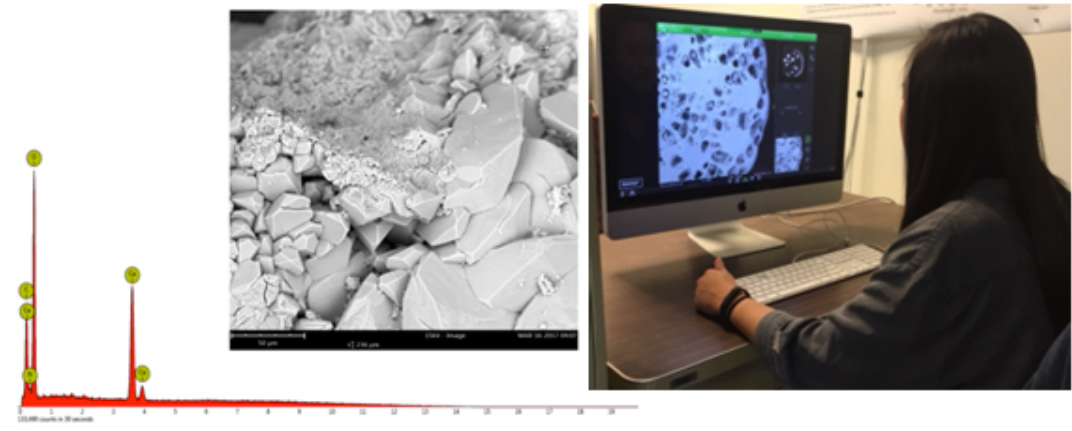
Figure 3. SEM image and EDS elemental analysis of limestone (calcium carbonate)